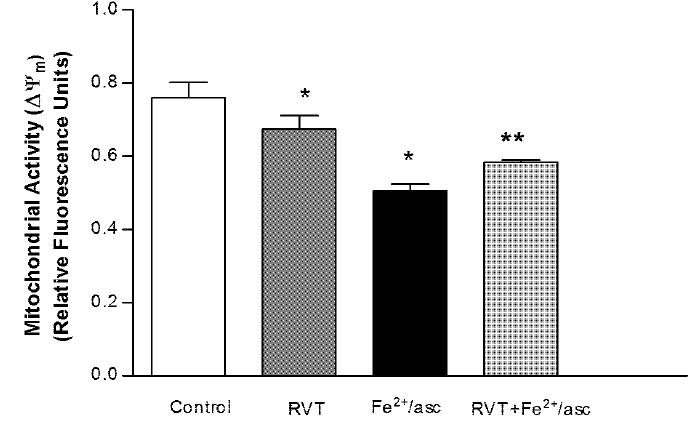
Figure 1. Effect of RVT on Δѱ . Spermatozoa were obtained from ductus deferens in m M-16 medium, pooled and incubated with RVT, Fe 2+ /asc or RVT + Fe 2+ /asc. Δѱ determined using the Mito Probe JC-1 assay kit and the fluorescence was measured on a spectrofluorometer. Values represent the mean ± SD of three independent experiments